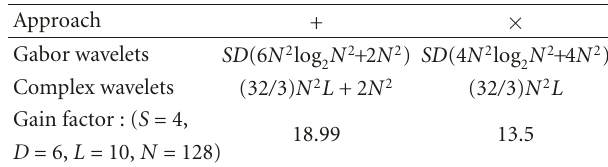
Table 7: Computational complexity analysis of feature extraction using Gabor wavelets, DT-CWT and ST-CWT ( N 2 : total images